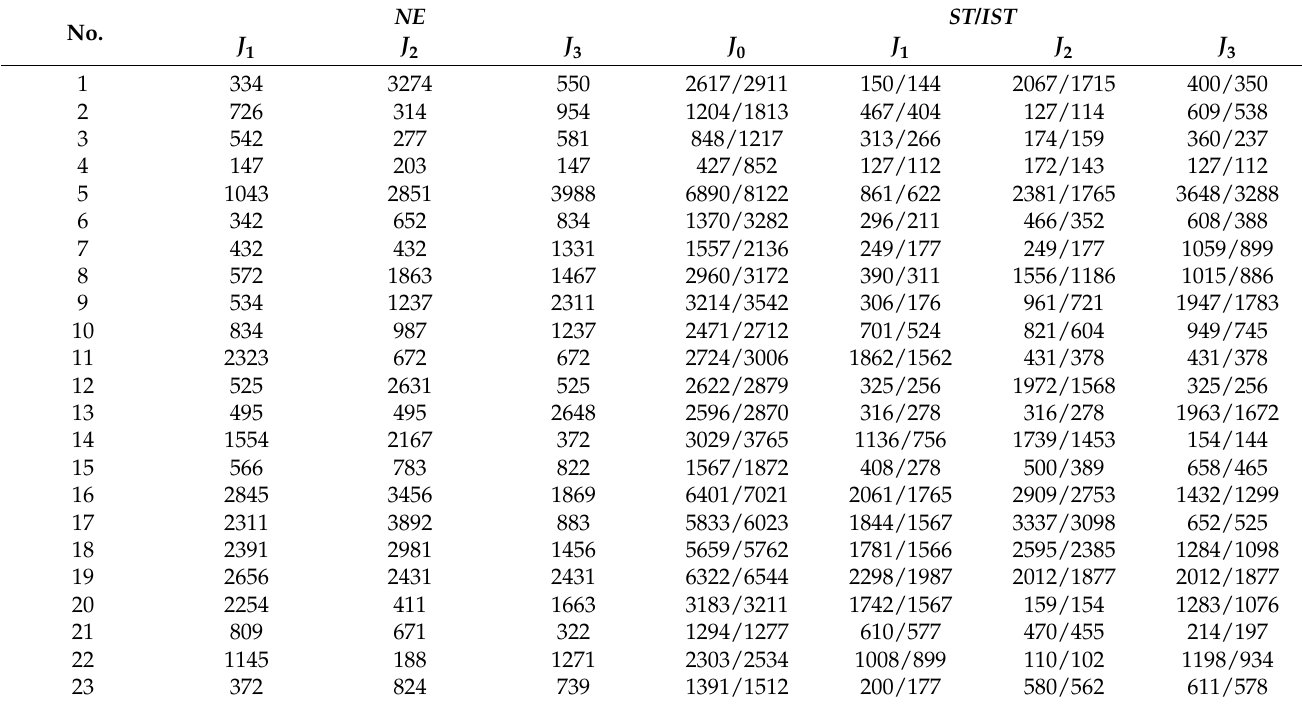
Table 9. Payoffs for different information structures with the green